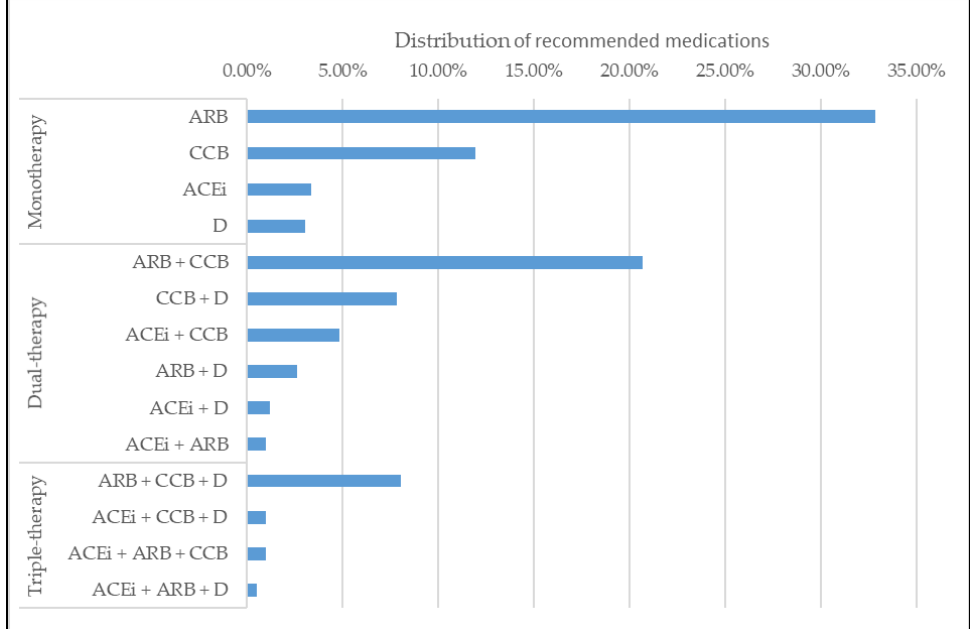
Figure 2. Distributions of recommended medications by model.